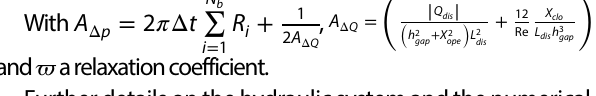
= 2 mm, ove = 5 mm, ove